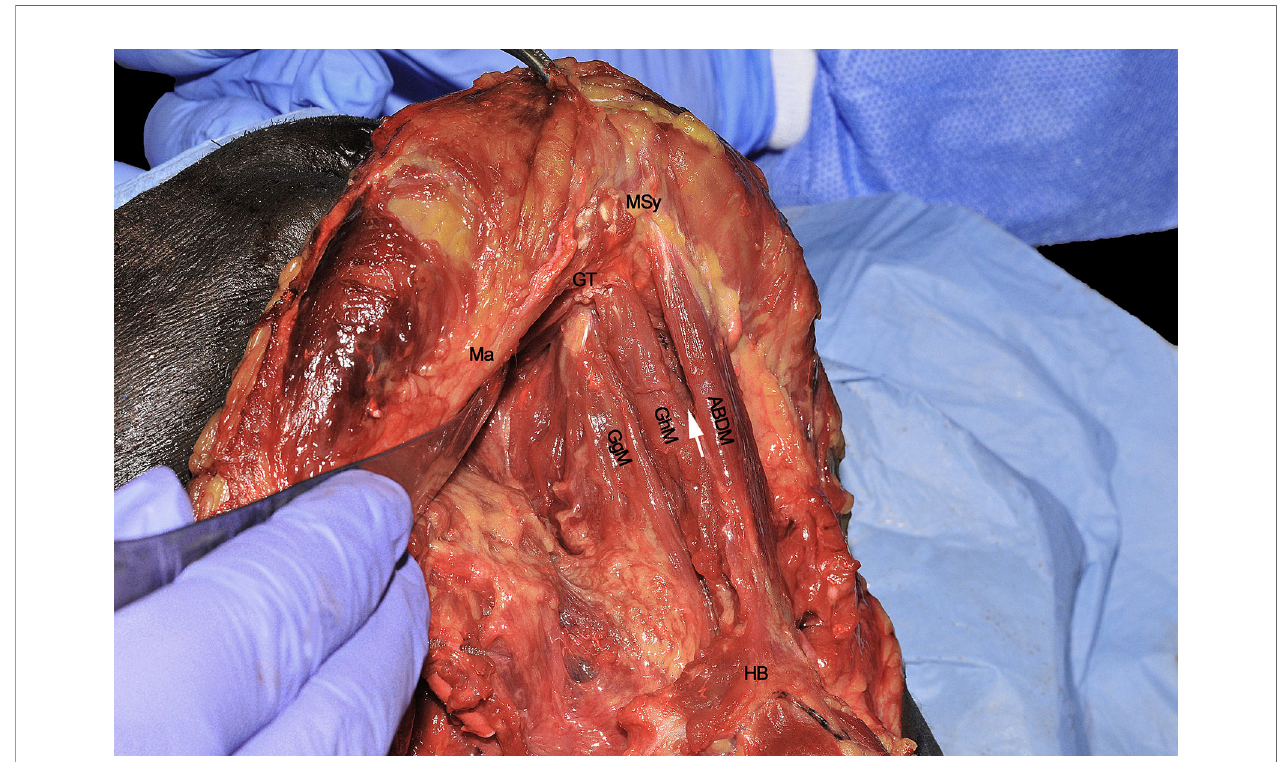
FIGURE 8 | ABDM, anterior belly of digastric muscle; GgM, genioglossus muscle; GhM, geniohyoid muscle; GT, genial tubercle; HB, hyoid bone; Ma, mandible; MSy, mandibular symphysis. White arrow, thin left mylohyoid muscle between the ipsilateral ABDM and